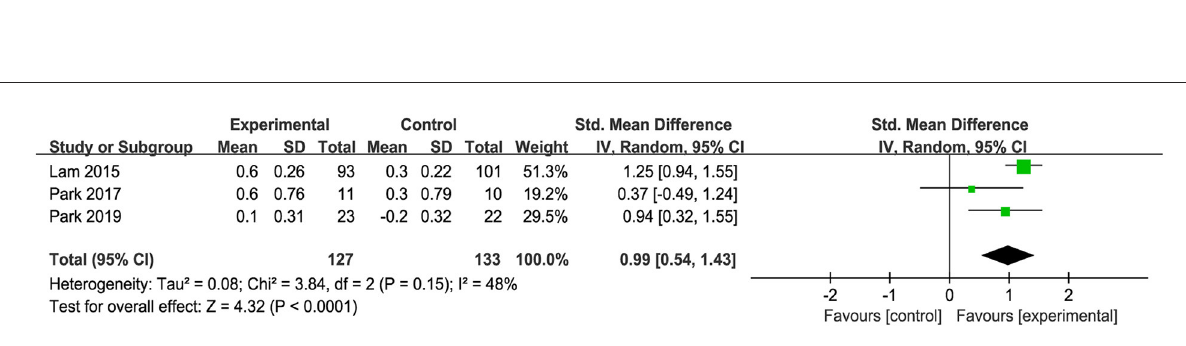
FIGURE7 Forest plot of the efficacy of the combined intervention on depression in older adults with MCI compared with the control